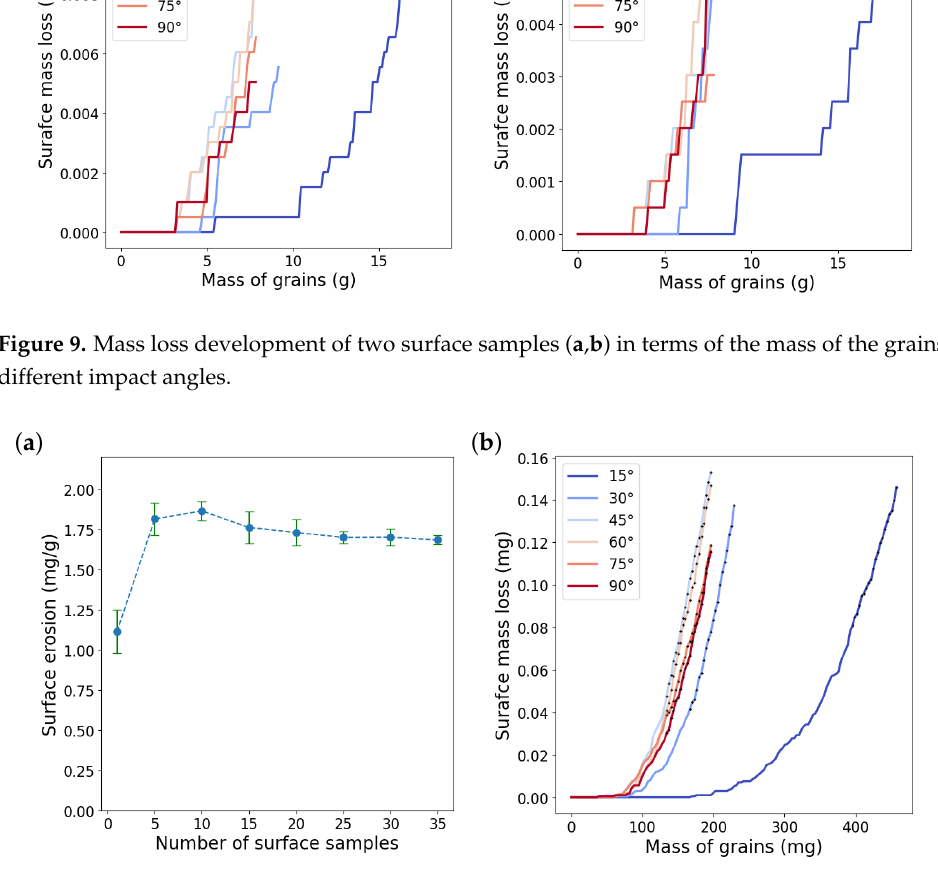
Figure 10. ( a ) Convergence of surface erosion in terms of the number of surface samples for impact angle of 45° and ( b ) mass loss obtained by averaging the results for 25 surface samples. These results are obtained for hexagonal grains with the distribution range of 1.0 D g . The black marks represent the data points used to estimate